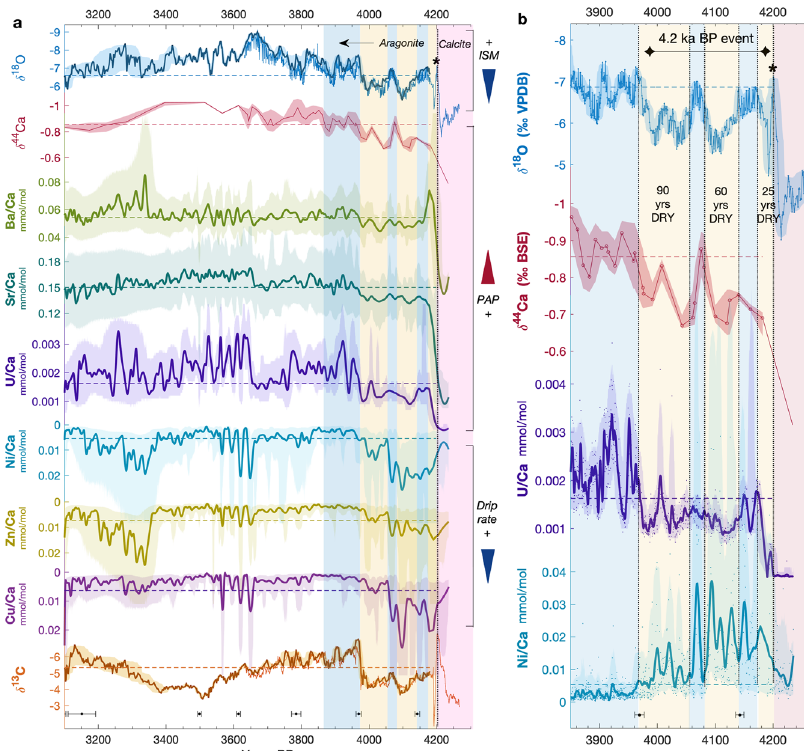
Fig. 2 DHAR-1 proxies from 4.2 to 3.1 ka BP. a 4.27 – 3.1 ka BP DHAR-1 record with high-resolution δ 18 O, δ 44 Ca, and δ 13 C stable isotope time series (note reverse axes) and Ba/Ca, Sr/Ca, U/Ca, Ni/Ca, Zn/Ca, and Cu/Ca trace element data shown as 20-year LOESS smoothing curves. Dominant processes for the proxies are indicated with arrows on the right (Indian Summer Monsoon, prior aragonite precipitation, and drip rate). δ 13 C is not speci fi ed because it is affected by a (variable) combination of prior aragonite precipitation, cave ventilation, and long-term soil carbon changes driven by vegetation above the cave. b 4.27 – 3.85 ka BP in more detail covering the 4.2 ka event, with δ 18 O and δ 44 Ca stable isotope time series, and U/Ca and Ni/Ca with 10-year LOESS smoothing curves. The asterisk represents the transition from calcite to aragonite after a hiatus. For each series, shaded envelopes represent the 2.5 and 97.5% proxy con fi dence intervals, and horizontal dashed lines show the mean value over 4.2 – 3.1 ka BP. Vertical shaded bars denote relatively dry (yellow) and wet (blue) intervals between 4.27 and 3.85 ka BP. U-series dates with ±2 σ error bars are shown at the bottom of the graphs above the lower age